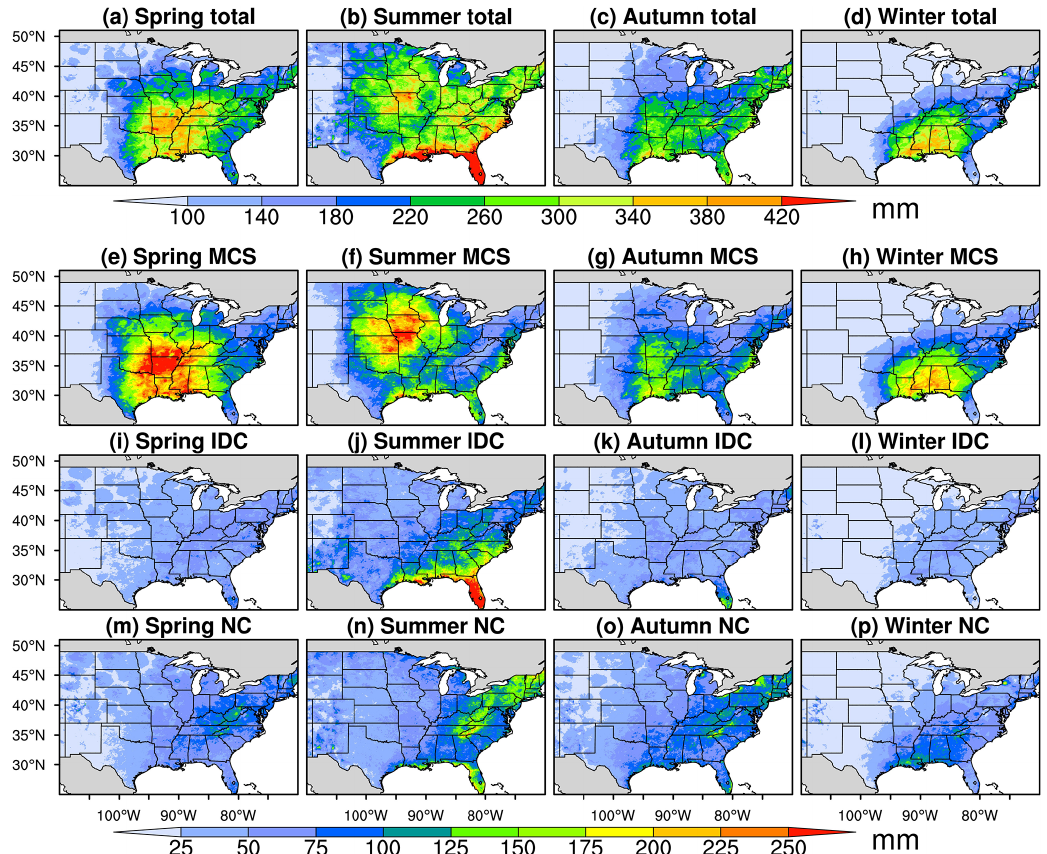
Figure 8. Distributions of annual mean seasonal precipitation amounts for different types of precipitation for 2004–2017. The first row is for total precipitation, the second for MCS precipitation, the third row for IDC precipitation, and the fourth row for NC precipitation. The first column shows spring precipitation, the second column summer, the third column autumn, and the fourth column winter. MCS, IDC, and NC precipitation values share the same label bar. We exclude hourly data with precipitation ≤ 1mmh − 1 in the